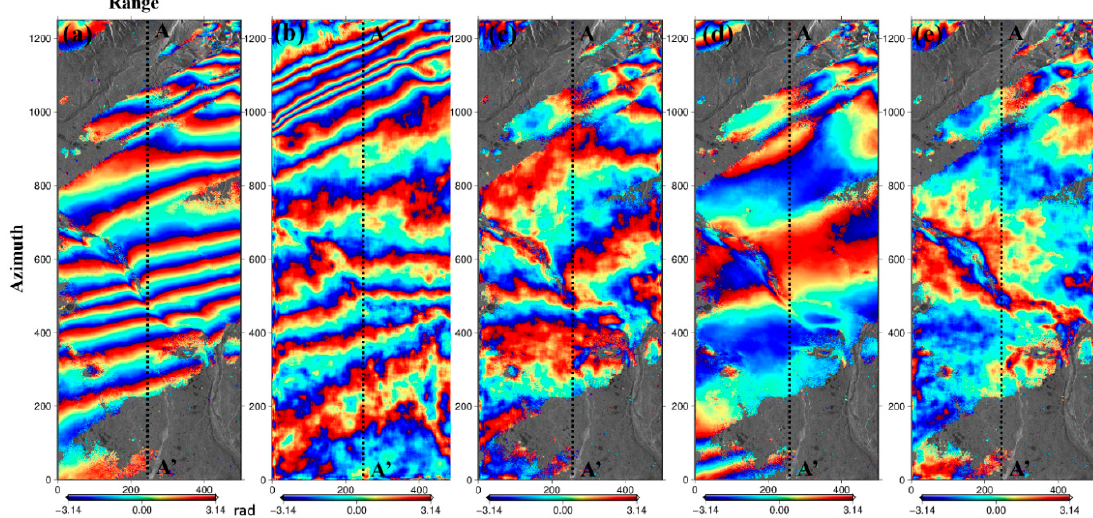
Figure 7. Horizontal- Horizontal (HH)-polarized original and corrected interferogram. ( a ) Original interferogram, ( b ) ionospheric phase map derived from (10), ( c ) ionosphere-corrected interferogram by subtracting Figure 7b from Figure 7a, ( d ) residual-ionosphere-corrected interferogram by subtracting the fitted residual ionospheric phase from Figure 7a, ( e ) integration-corrected interferogram by subtracting the fitted phase in (11) from Figure 7a.